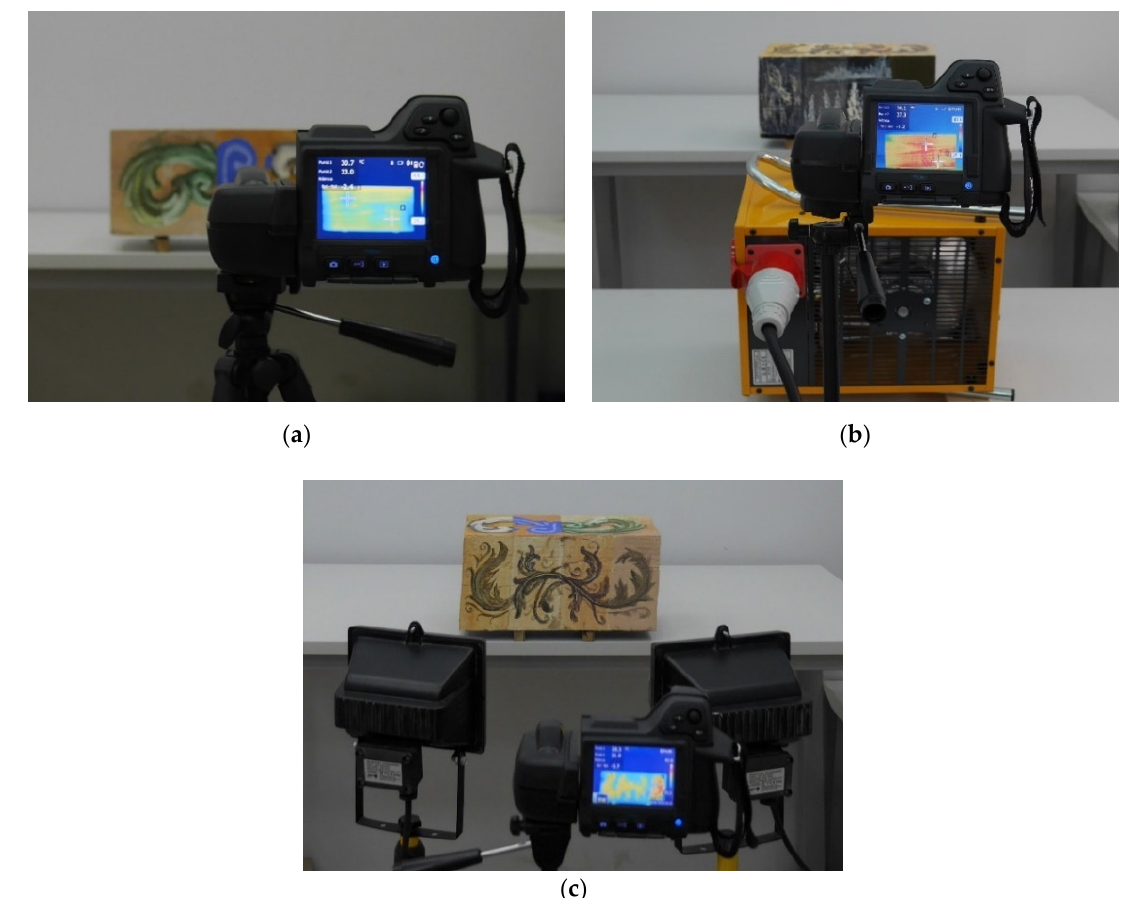
Figure 4. A view of the test stands for active thermography examinations: ( a ) after preheating in laboratory dryer, ( b ) during air-heating and ( c ) during heating with halogen lamps.